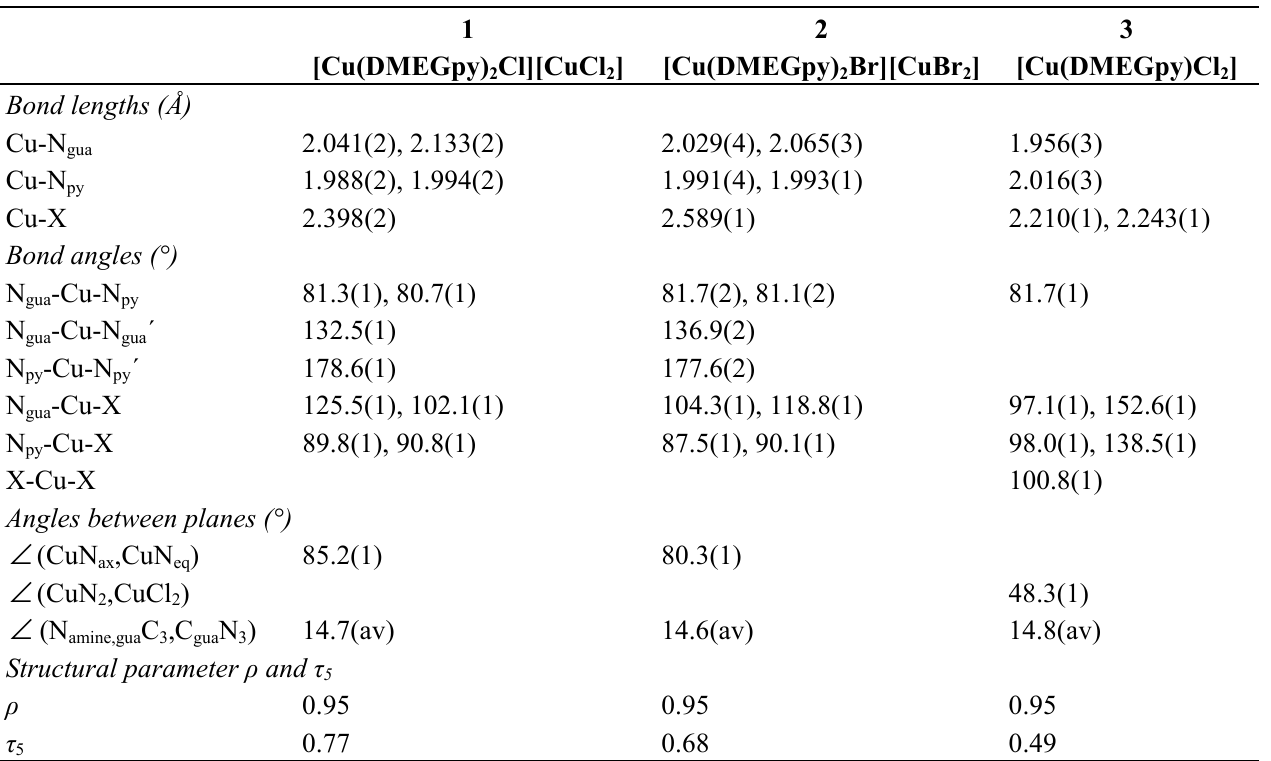
Table 2. Key geometric parameters of Complexes 1–3 .